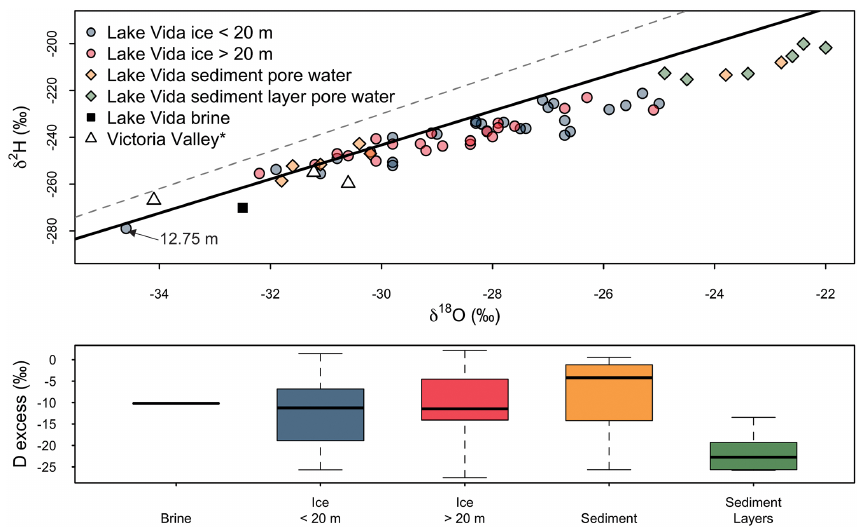
Figure 6. (a) Stable isotope composition of hydrogen ( δ 2 H) and oxygen ( δ 18 O) in Lake Vida ice, pore water in thin sediment pockets and thick sediment layers, and brine. Published values for Victoria Valley surface water and snow are denoted by black triangles (Hagedorn et al., 2010). The local meteoric water line of glacial water (solid line, Gooseff et al., 2006) and global meteoric water line (dashed line) are plotted for reference. (b) Box and whisker plot of deuterium excess values for brine ( n = 1), ice samples above 20m ( n = 25), ice samples below 20m ( n = 26), thin sediment pockets ( n = 7), and sediment layers ( n = 6). The thick black line represents the median values, and box edges represent the 25th and 75th quantiles. Whisker lines extend to the extreme